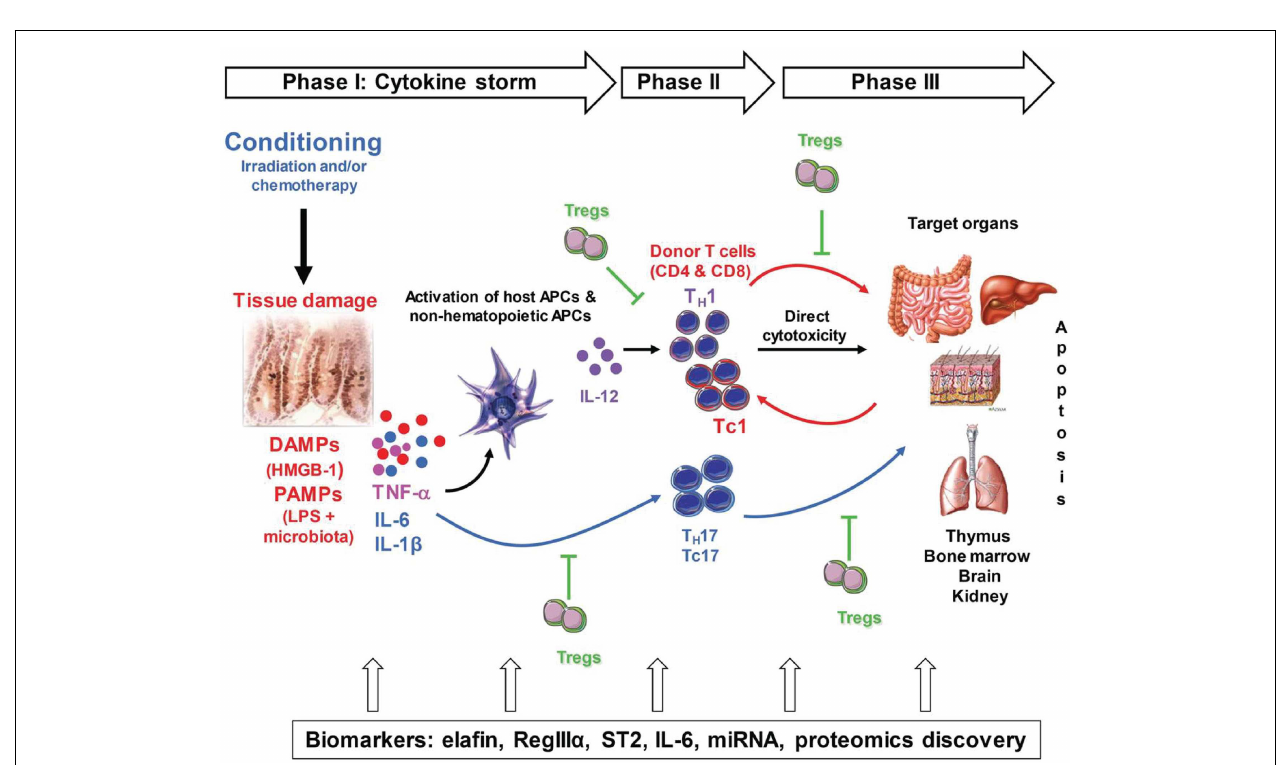
organs (i.e., GI tract, liver, skin) and amplify local tissue destruction.The presence of regulatoryT-cells (Tregs) helps reduce GVHD severity through the inhibition of pathogenic cells activation and/or expansion at early or further phases of GVHD. Some of these DAMPs and PAMPs such as elafin (skin-specific), regenerating islet-derived 3-alpha (REG3 α , gut-specific), and suppressor of tumorigenicity 2 (ST2, a member of the IL-1 receptor family, binding IL-33) have been shown to be